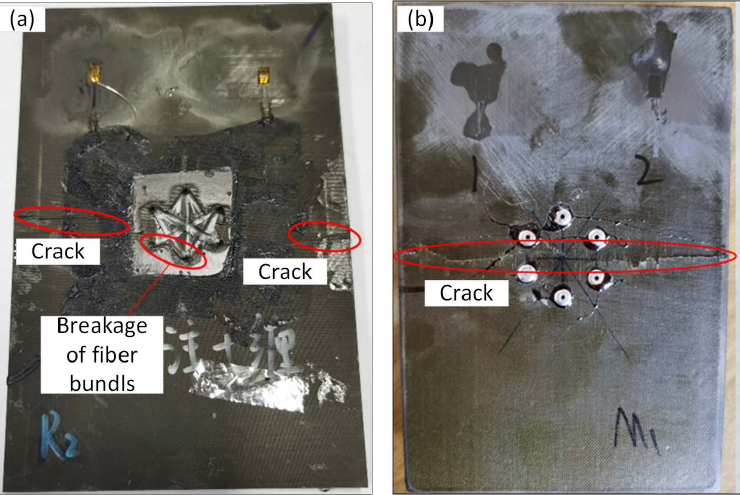
Figure 18. Photographs of broken specimens repaired with T700 fiber bundles ( a ) and aluminum rivets ( b